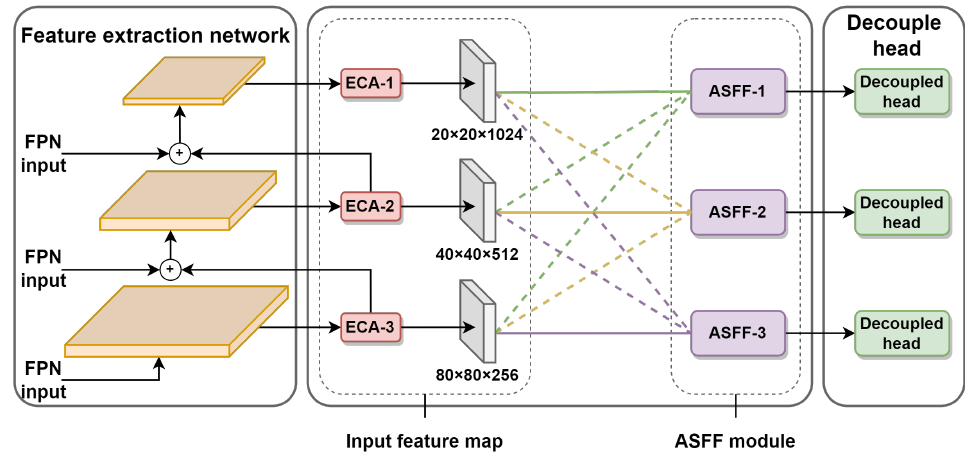
Figure 4. An overview of the ASFF module with attention mechanism.